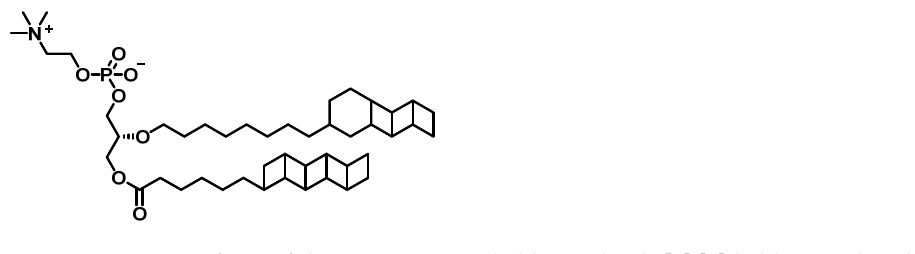
Figure 1. Structure of one of the most common ladderane lipids [5]-[3]-ladderane phosphatidylcholine, which is an abundantly and commonly found ladderane lipid in anammox bacteria.